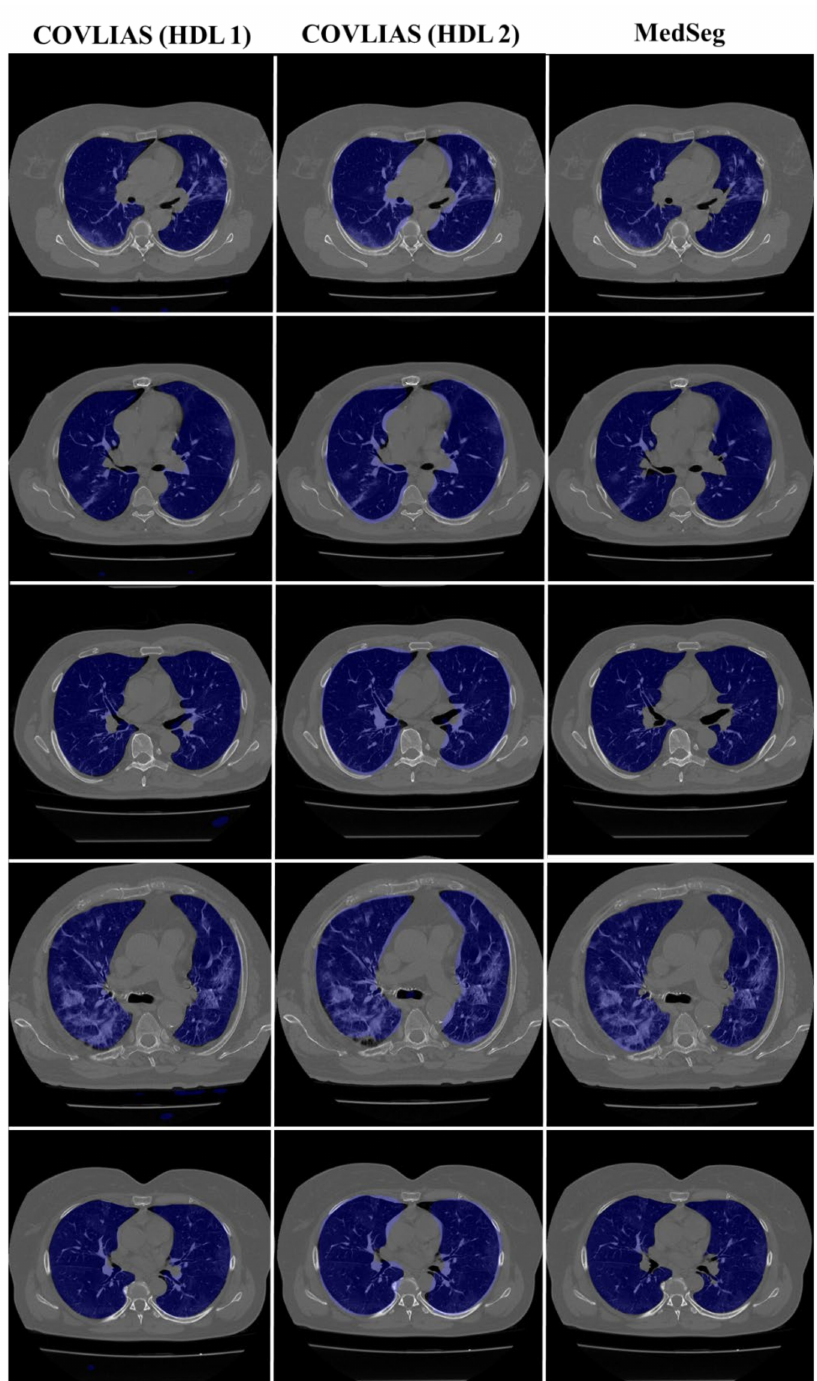
Figure 20. COVLIAS vs. MedSeg: Segmented mask (blue) on the raw CT CROATIA lung